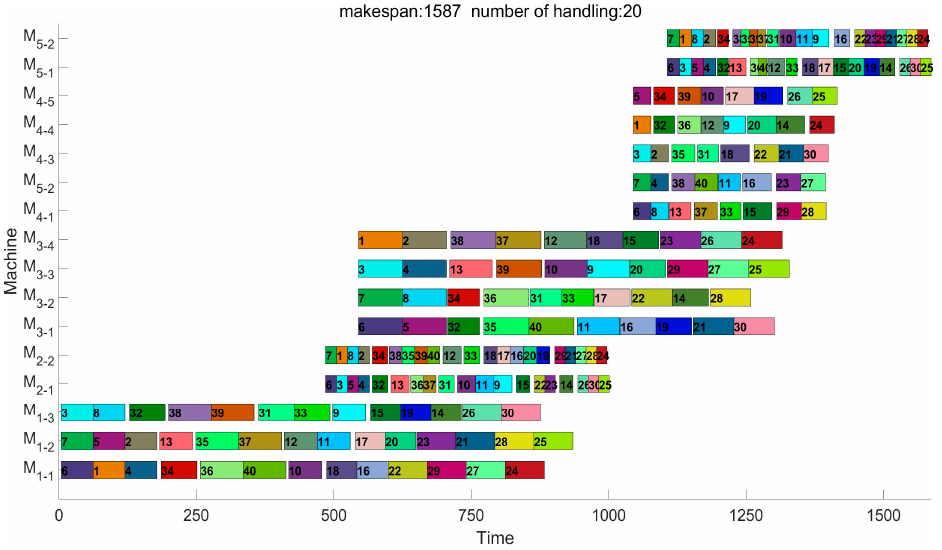
Figure 8. Non-dominated solution Gantt chart.